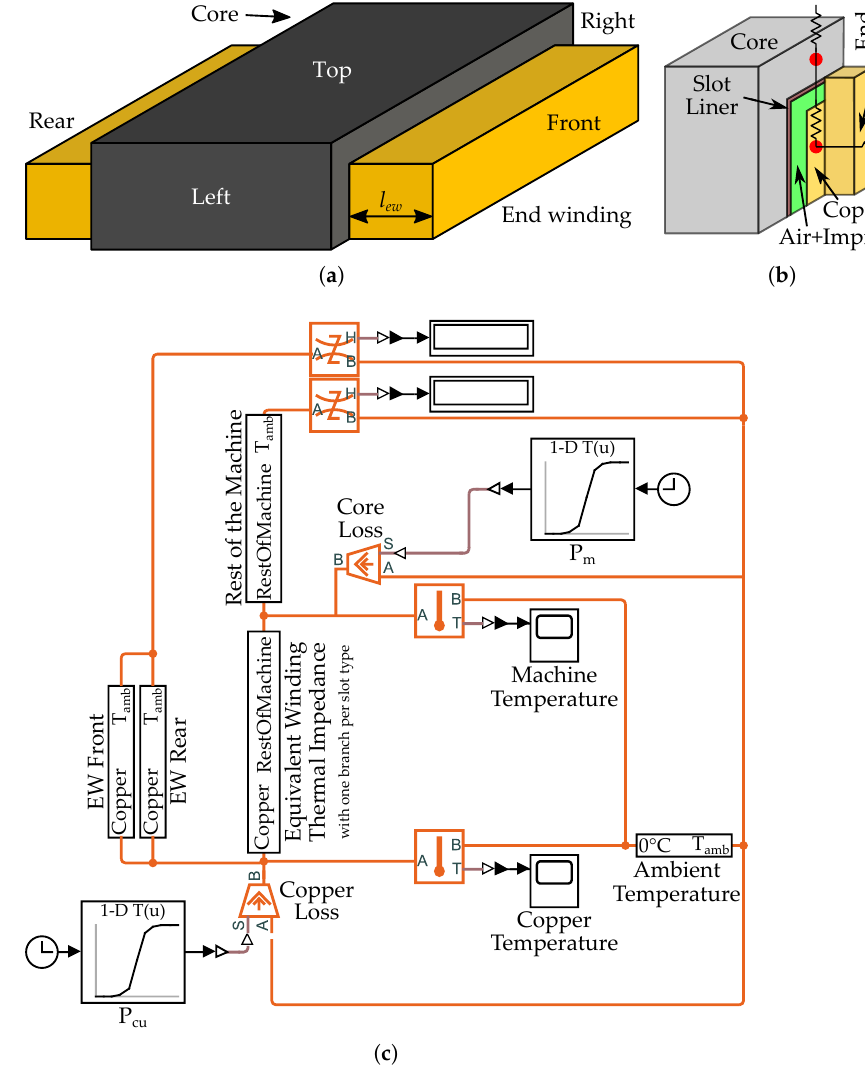
Figure 1. General view of the thermal model. ( a ) Simplified geometry. ( b ) Modeled elements. ( c ) General view of the thermal LP